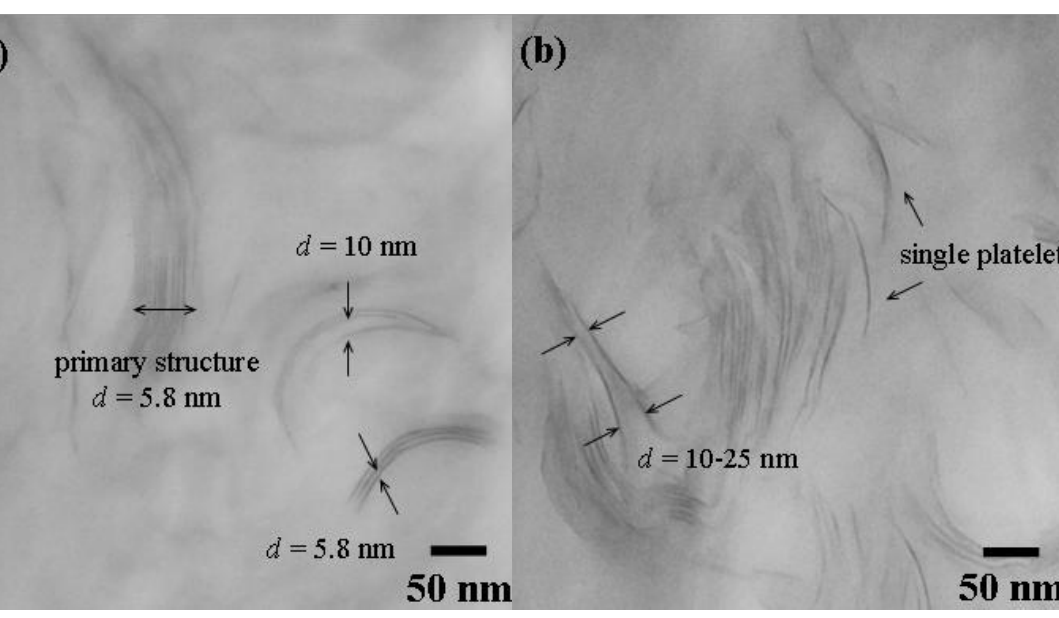
Figure 2. Comparative TEM micrographs of 3 wt % (a) MMT/POP2000 and (b) MMT/AMO in cured epoxies (reprinted with permission from reference [76]).